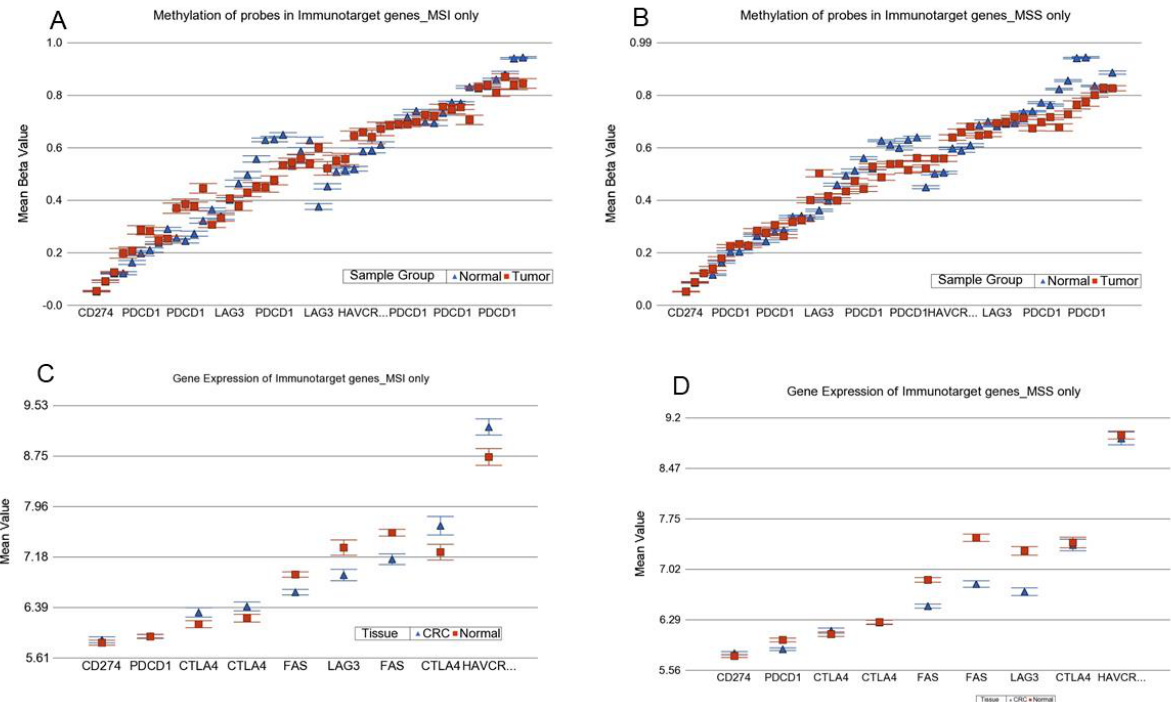
Figure 9. Differential methylation and gene expression of immune target genes in MSI and MSS colon cancer. In the upper panel, Figure ( A , B ) show multiple probes for differential methylation on the x-axis and the beta value on the y-axis for MSI and MSS CRC, respectively. In the lower panel, Figure ( C , D ) show multiple probes for gene expression on the x-axis and the log 2 -transformed expression value on the y-axis for MSI and MSS CRC, respectively.